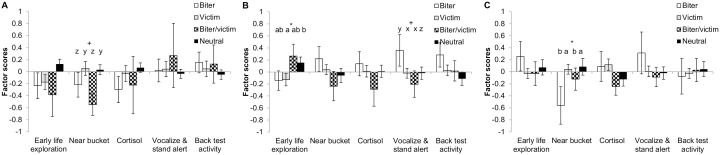
Factor scores of barren housed pigs classified as biters, victims, biter/victims or neutrals with respect to tail biting post-weaning.Behavioural and physiological responses of pigs to novelty (pre- and post-weaning) were summarized in five factors using a PCA. Factor scores are presented per type of pig, i.e. tail biter, victim (with tail wound), both tail biter and victim (biter/victim), or pigs that were neither tail biter or victim (neutral). A: Phase 1 post-weaning. B: Phase 2 post-weaning. C: Phase 3 post-weaning. +P<0.10, *P<0.05. Pig types lacking a common letter differ significantly (a/b) or tend to do so (x/y/z).